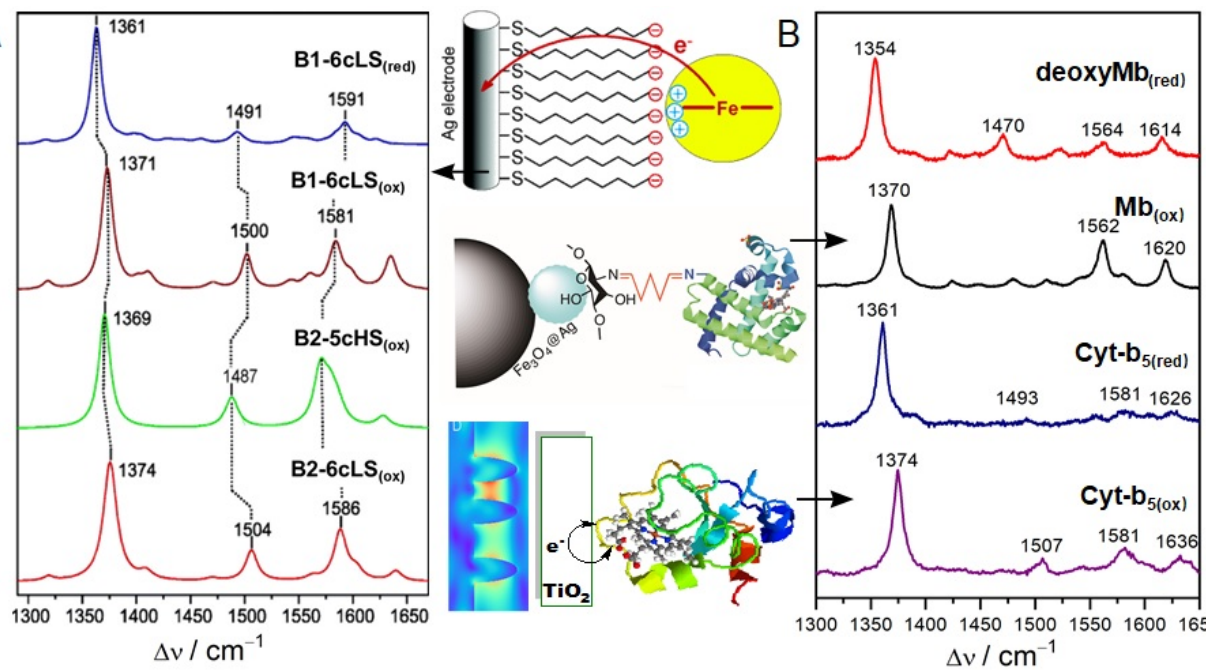
Figure 5. SERRS of hemoproteins including Cyt-c, Mb, and Cyt-b 5 . ( A ) SERRS of different oxidation, spin, and coordination states of Cyt-c immobilized on a CO 2 -SAM Ag electrode measured with 413 nm excitation. Reprinted with permission from [49]. Copyright [2004] American Chemical Society. ( B ) (Black) SERRS of deoxyMb (red) and Mb (ox) on a magnetic-Ag hybrid material (adapted with permission from [40]. Copyright [2013] American Chemical Society), and (purple) two redox states of Cyt-b 5 on a TiO 2 electrode (adapted with permission from [33]. Copyright [2013] John Wiley and Sons).